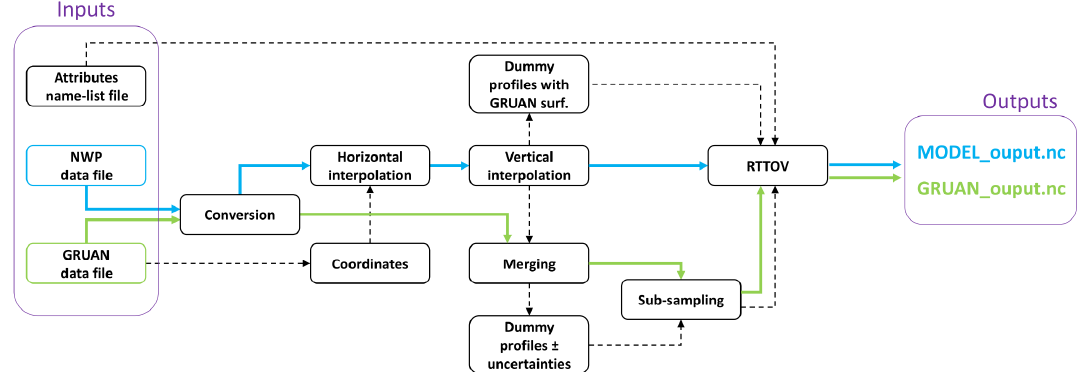
Figure 1. GRUAN processor top-level design. Solid arrows show the main processing steps from input (blue for NWP model data and green for GRUAN data) to output. Dashed arrows represent the internal